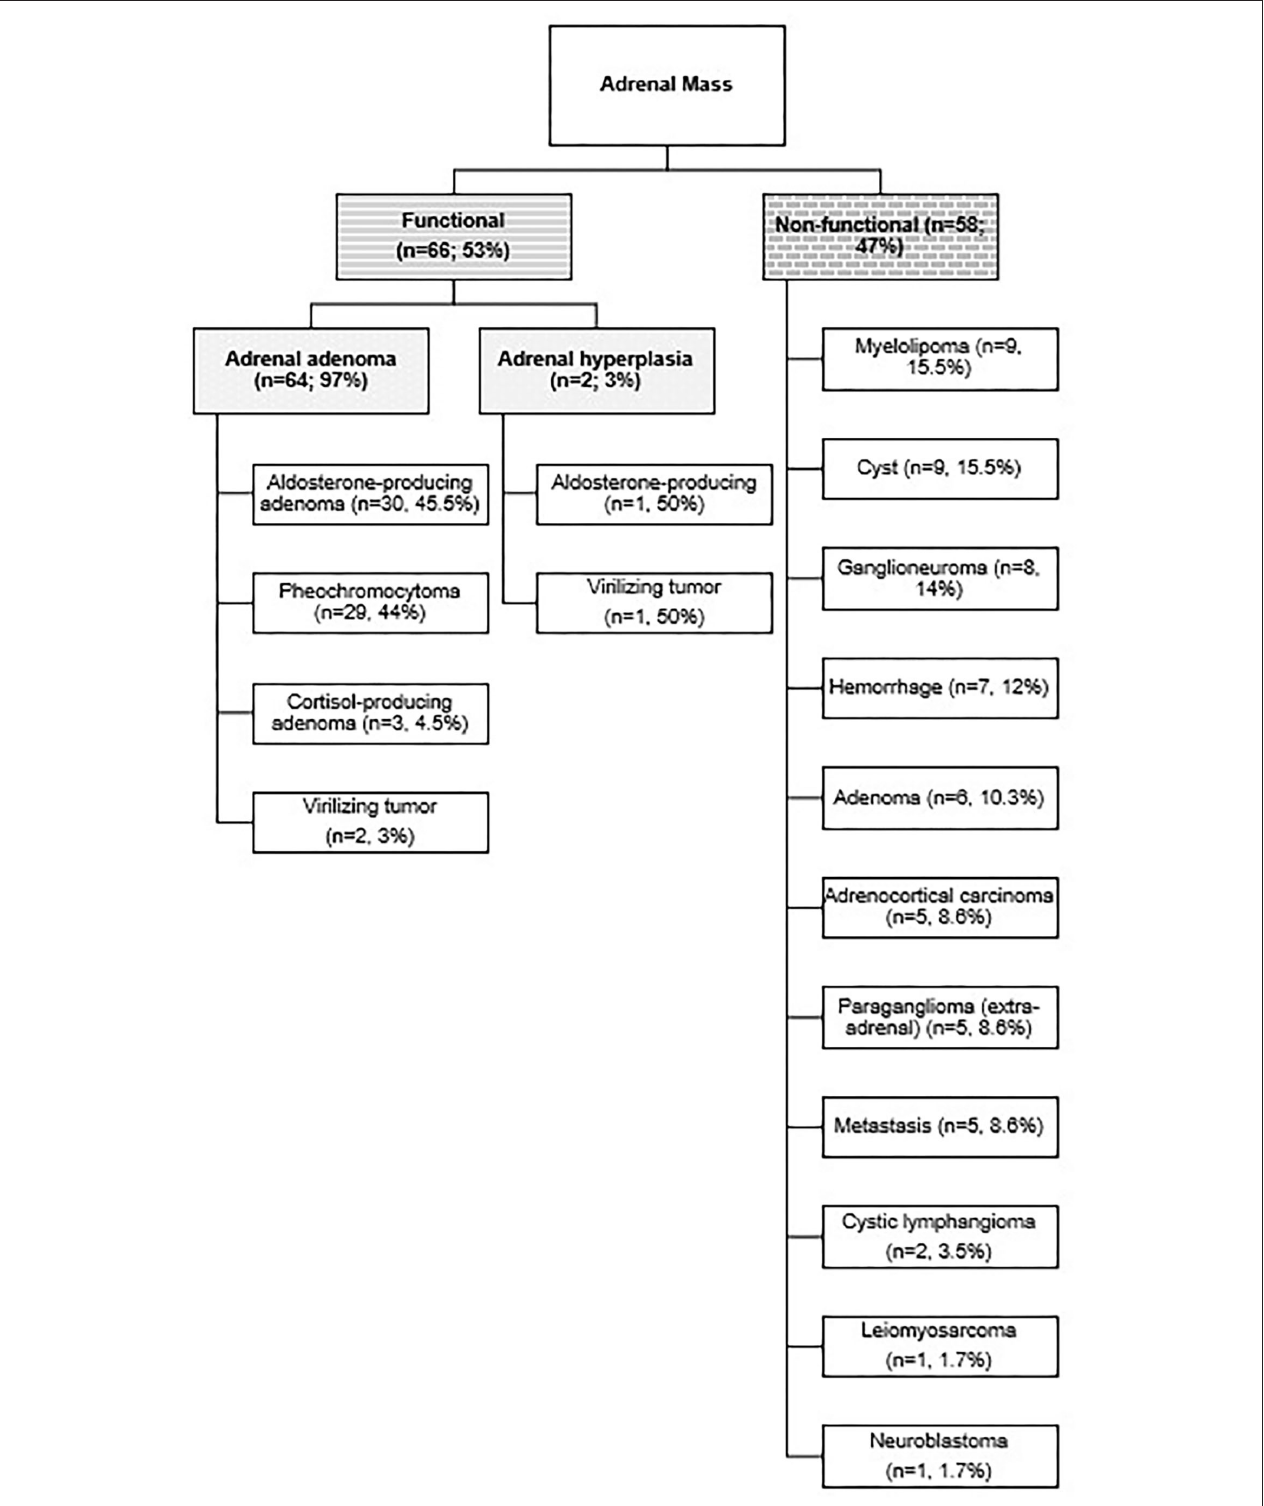
FIGURE 1 | The distribution of adrenal mass in terms of functionality and hormone production.